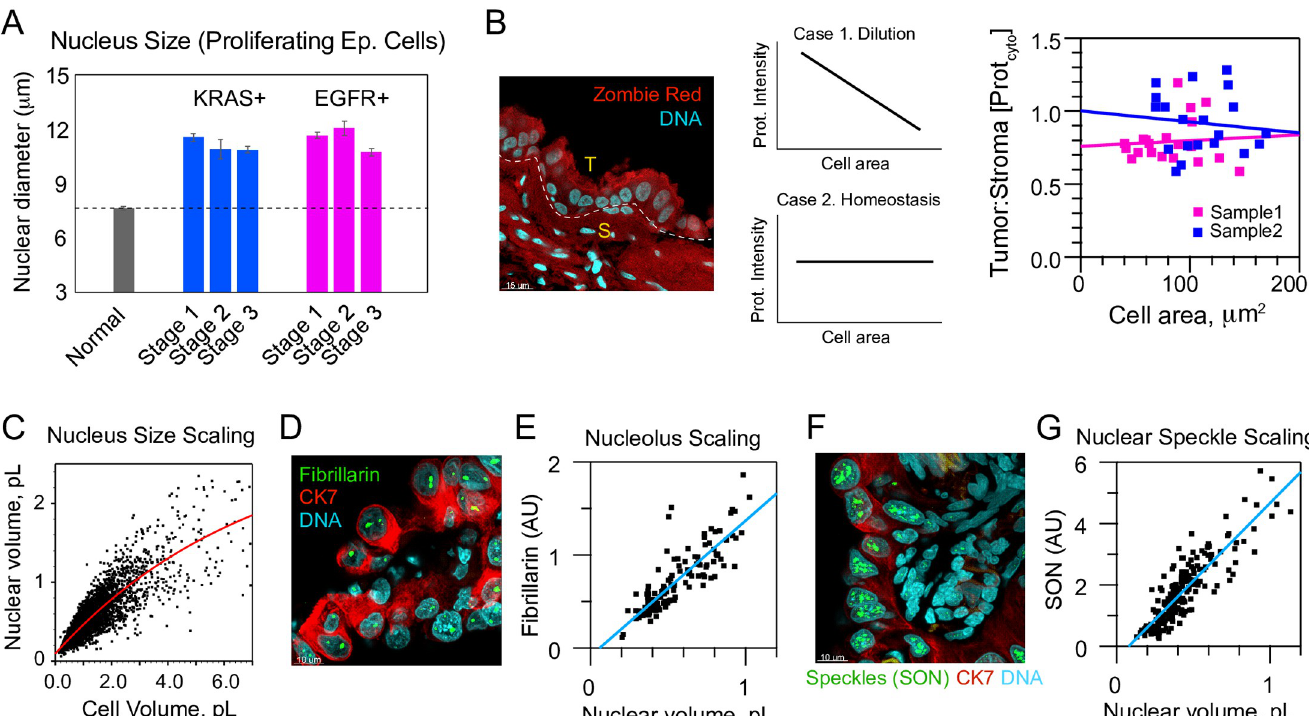
Fig 7. Enlarged EGFR+ or KRAS+ lung adenocarcinoma cells can proliferate, possess similar protein density to stroma, and display organelle size scaling. A. Nucleus sizes from proliferating EGFR+ and KRAS+ tumor cells identified by Ki-67 staining, relative to non-proliferative normal AT2 cells (N EGFR = 8, N KRAS = 8, n = 435). B., Zombie Red (red) is a broadly amine-reactive dye that in these FFPE samples reacts equally with small stromal cells, S, as it does with enlarged cancer cells, T, which is inconsistent with cells swelling via water uptake (N = 2). DNA stained with TO-PRO-3 (cyan). Right, Zombie Red intensity of KRAS+ tumors, a proxy for protein density in the cell, does not show the downward trend with cell area expected for water-diluted cells (N = 2, n = 20). C. Allometry of nuclear volume as a function of cell volume for LA (N = 21, n = 2082). Red line, double exponential fit to data. D., Fibrillarin (green) marks nucleoli comparing tumor cells of varying size in a KRAS+ stage 3 patient’s tumor (ID# 4855). CK7 (red), TO-PRO-3 (cyan). E., Total fibrillarin content in nuclei scales with segmented nuclear volume as expected for productive nucleoli (related to D., N = 1, n = 212). F., SON (green) marks nuclear speckles (also KRAS+ patient 4855). CK7 (red), TO-PRO-3 (cyan). G., Quantification of total SON content shows speckles also scale with segmented nuclear volume as they do in living cells (related to G., N = 1, n =